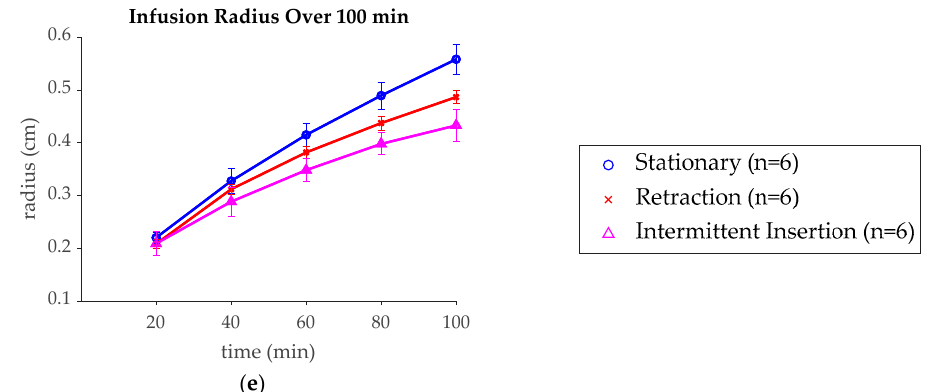
Figure 4. Plots of the ( a ) volume dispersed ( V d ); ( b ) forward volume dispersed ( V df ); ( c ) backflow distance; ( d ) forward flow distance; and ( e ) infusion radius for the stationary, retraction, and intermittent insertion groups at 20 min intervals throughout the 100 min infusion.